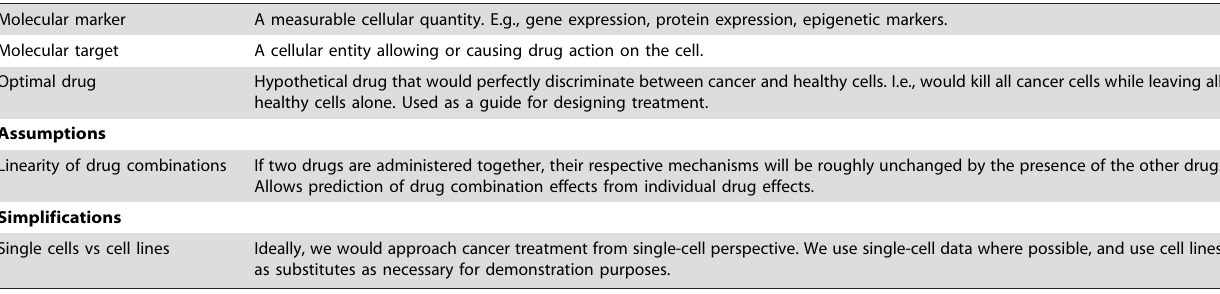
Molecular target Optimal